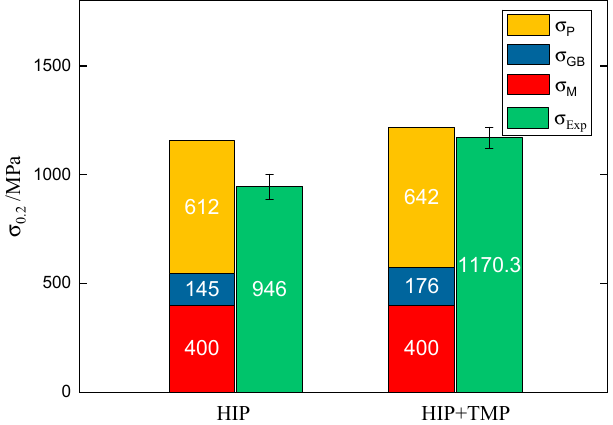
Figure 8. Comparison of experimental and calculated yield stresses of Al and Zr added 15Cr-ODS alloy. Table 2. Calculated yield stress values and experimental yield stress values of Al and Zr added 15Cr- ODS alloy before and after TMP.